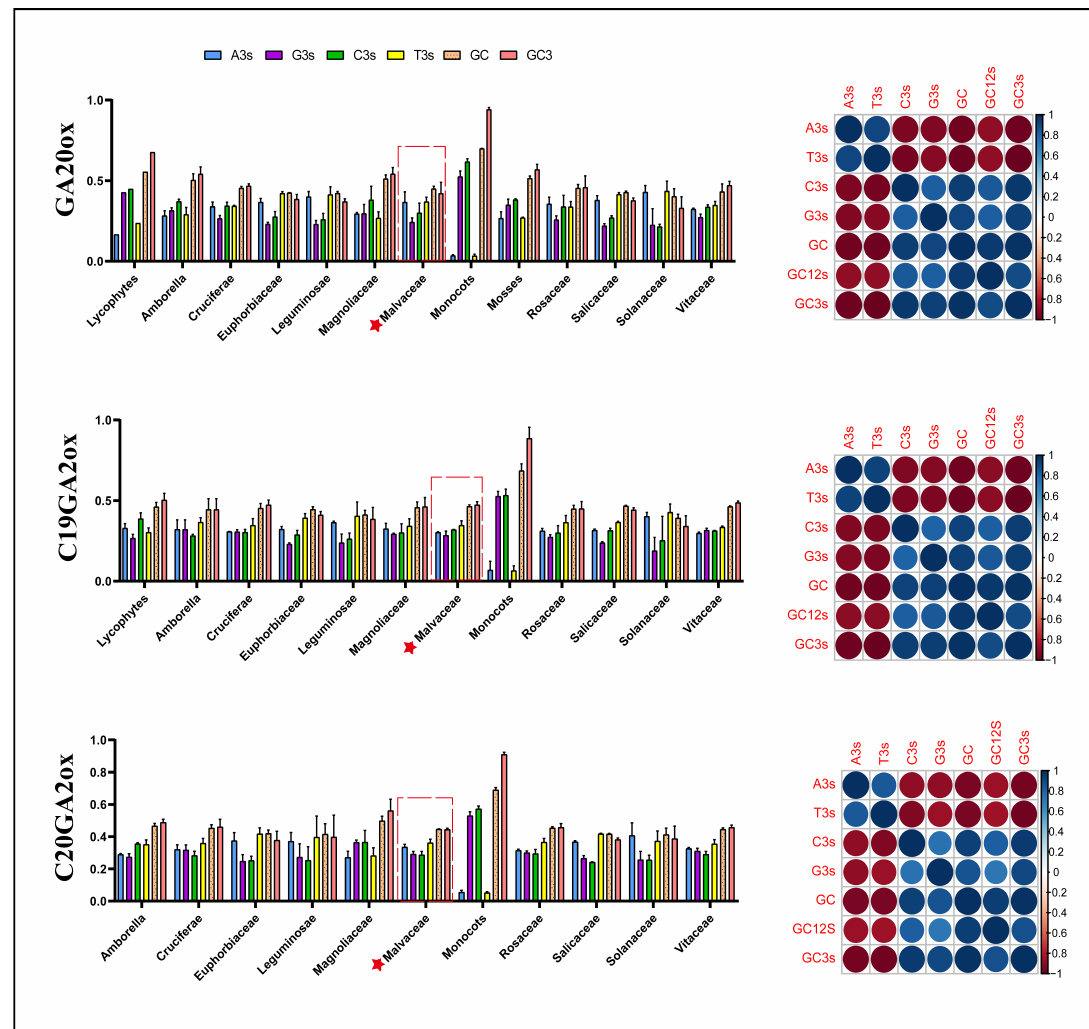
Figure 5. The bases in the third statistics and correlation analysis of GA20ox , C19GA2ox , and C20GA2ox in 21 species. The different color represents the third base frequency in codon. The red star and red dotted frame represent the L. chinense frequency of related bases in GA20ox , C19GA2ox , and C20GA2ox